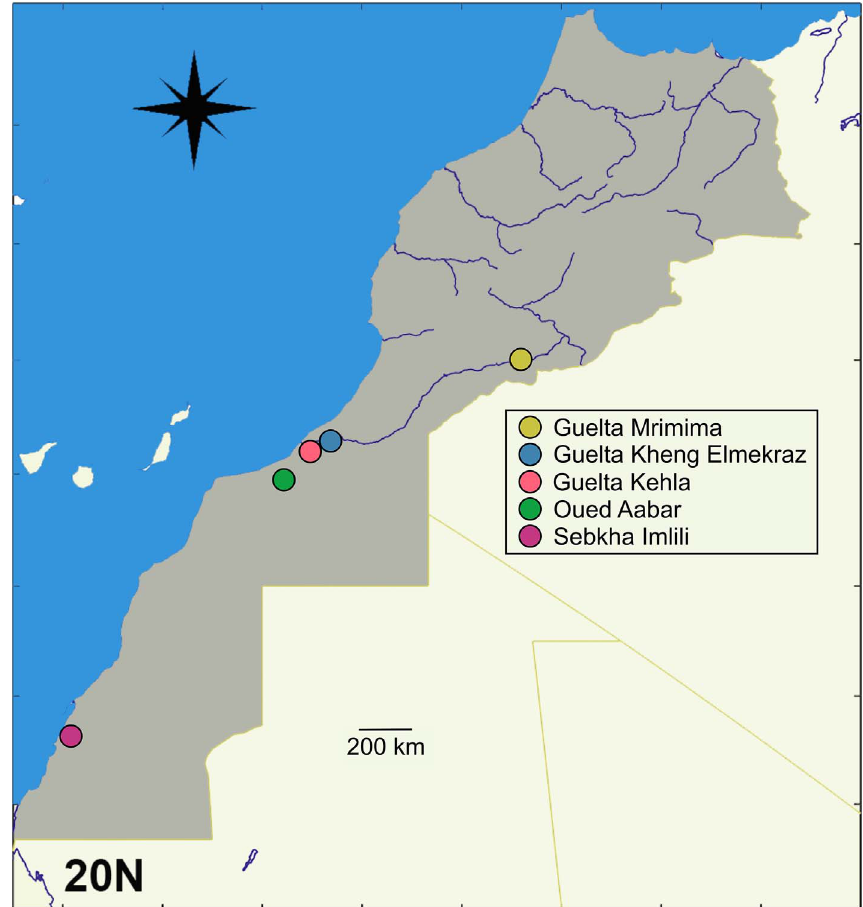
Figure 1. Map of Morocco indicating the sampling